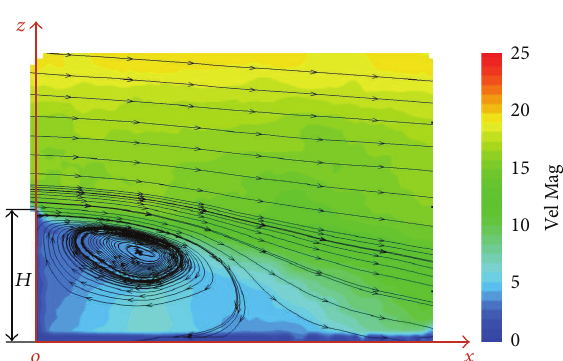
Figure 6: Velocity map in the vertical plane of symmetry of the SFS flight deck.